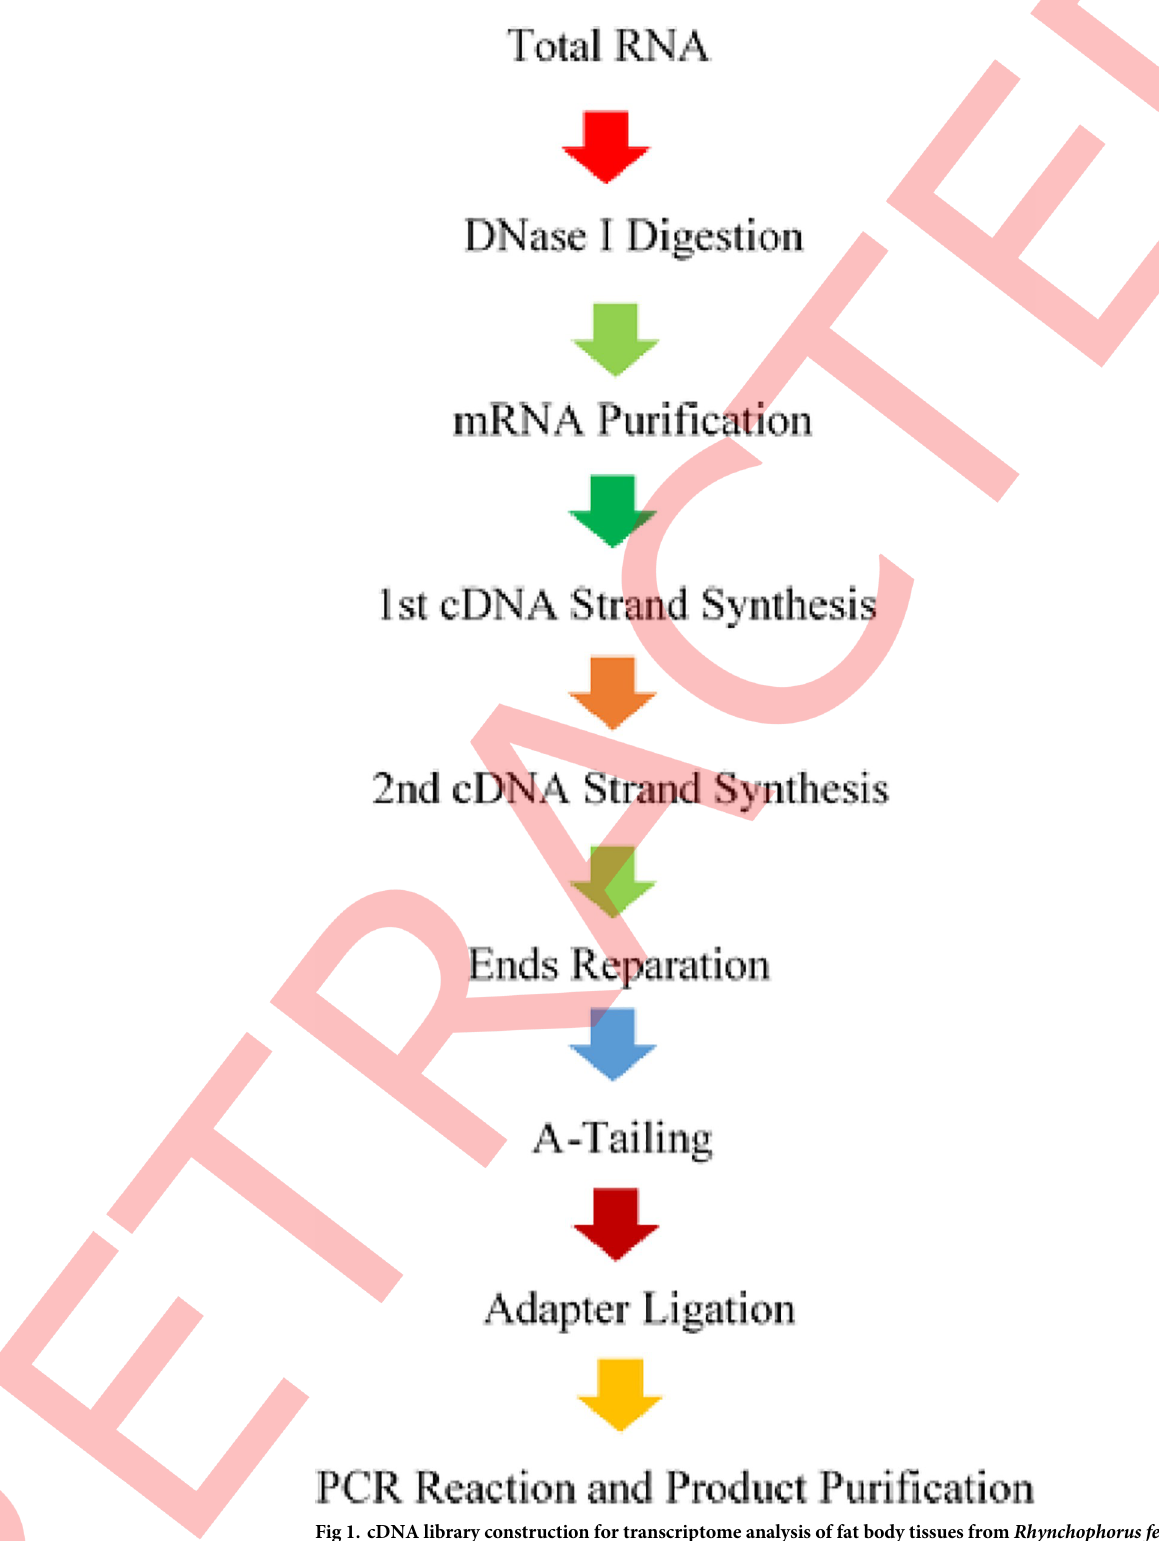
Fig 1. cDNA library construction for transcriptome analysis of fat body tissues from Rhynchophorus ferrugineus .